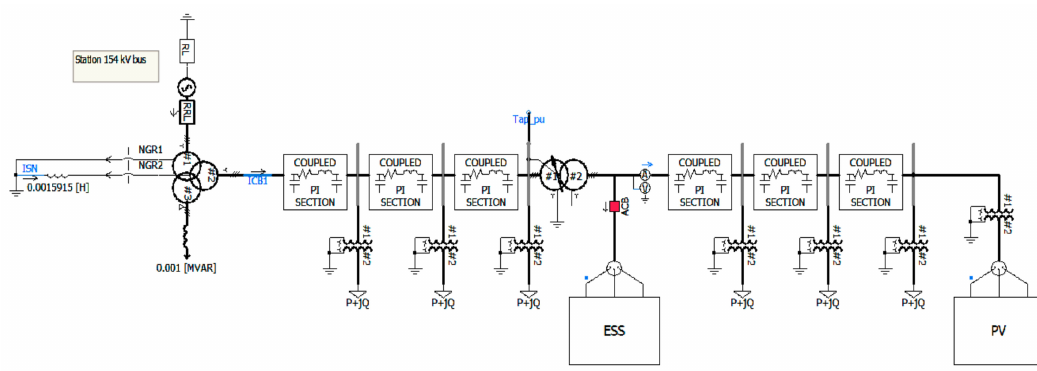
Figure 3. Distribution power system